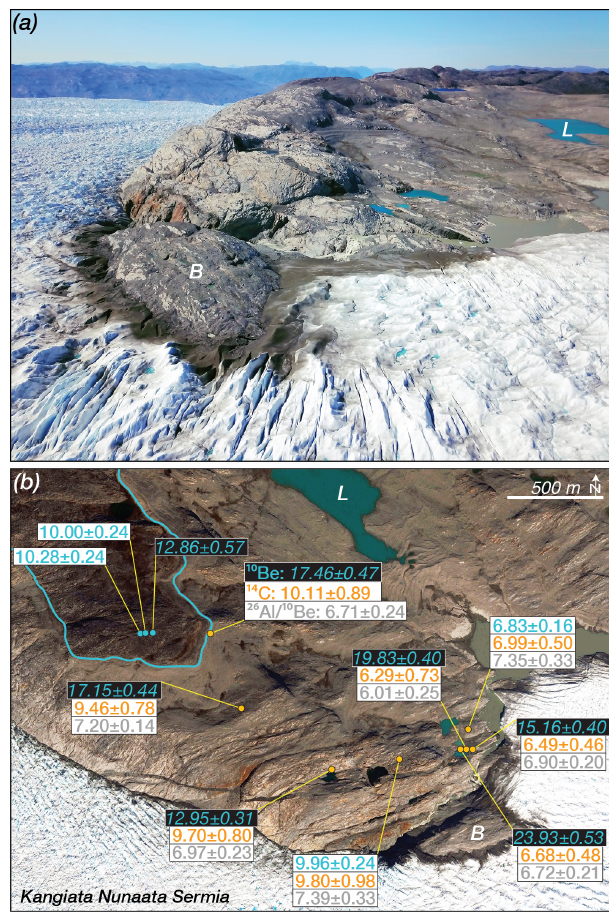
Figure 9. (a) Oblique aerial view to the northwest depicting re- cently deglaciated bedrock that rests between the historical maxi- mum extent and the modern ice margin on the northeastern side of KNS. (b) 10 Be and in situ 14 C ages (ka ± 1SD), along with mea- sured 26 Al / 10 Be ratios, at each bedrock sample site. 10 Be ages in- fluenced by inheritance are in black boxes with italics. The histori- cal maximum extent of KNS is marked in blue. To orient the reader, L and B mark the same feature in each panel. Map data: © Google Maps, Maxar